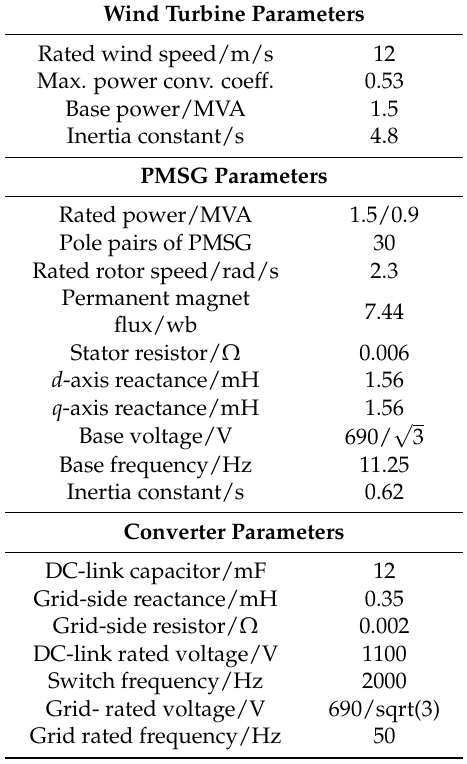
Table 1. The parameters of the PMSG wind power system for simulation.